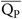
System response to variations in mean pump flow (QP-) for baseline and three test conditions.Fig. also shows the superimposed control line (CL), where the minimum scaling factor (K) that allows the aortic valve to be closed in the baseline condition was chosen. LVC, left ventricular contractility; PLVED, left ventricular end-diastolic pressure; Qp-, mean pump flow; Arrows indicate points where the aortic valve starts to open.